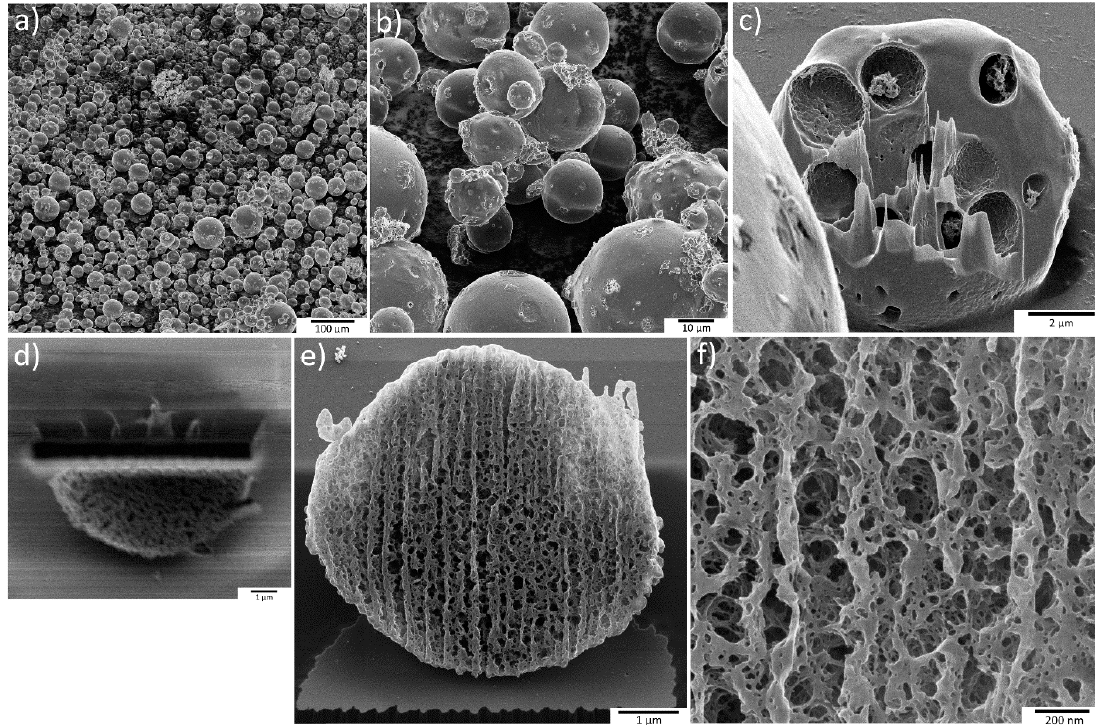
Figure 3. HIM images of freeze-dried and CPD-dried microcapsules: ( a ) Freeze-dried sample with a 1-mm field of view and ( b ) with higher magnification, and ( c ) a microcapsule having a particle size of about 10 µm was cut in half using a Ne + beam and, after a 180° rotation, was imaged with He + . ( d ) A CPD-dried microparticle was also milled with the Ne + beam. ( e ) After 180° rotation, the cut surface was imaged with He + . ( f ) A higher magnification image of the cross section shows the internal porous matrix of the polymer.